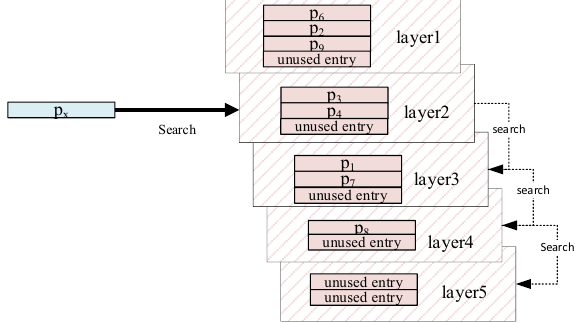
Fig. 7 An example of adding the rule to the layered TCAM